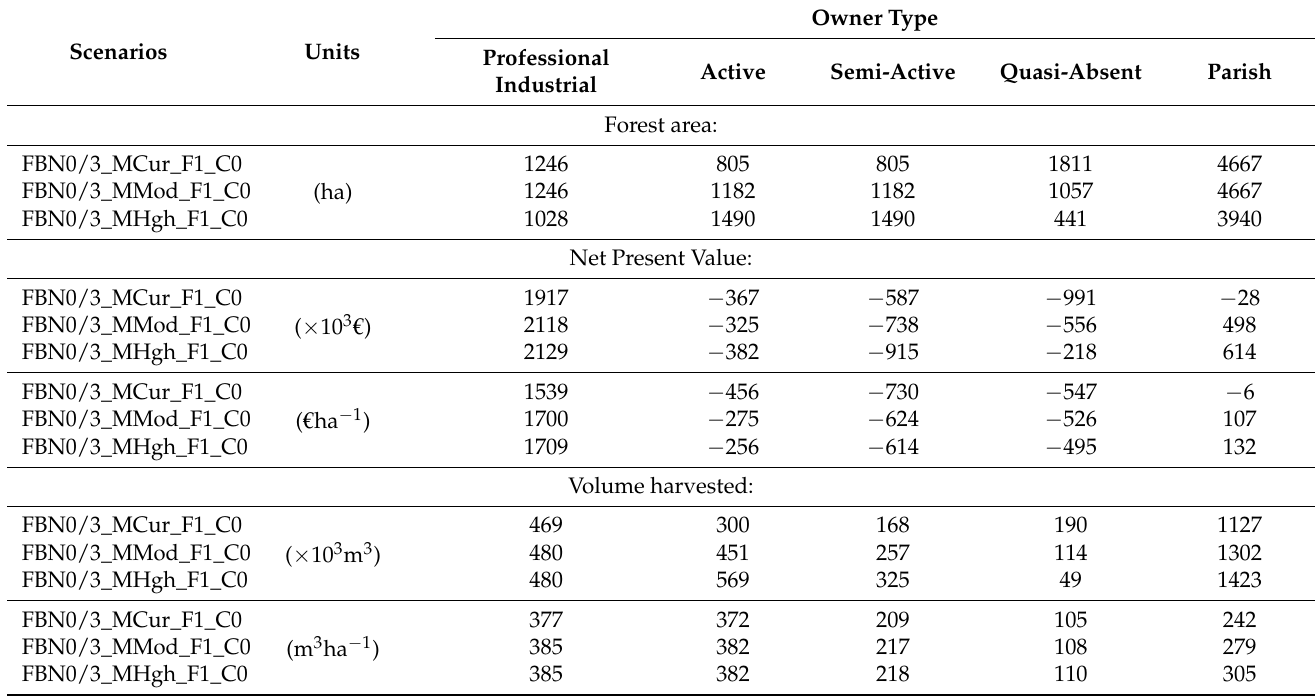
Table 5. NPV ( € and € ha − 1 ) and volume harvested (m 3 and m 3 ha − 1 ) by owner type and at parish level for the management improvement scenarios considering no-FBN